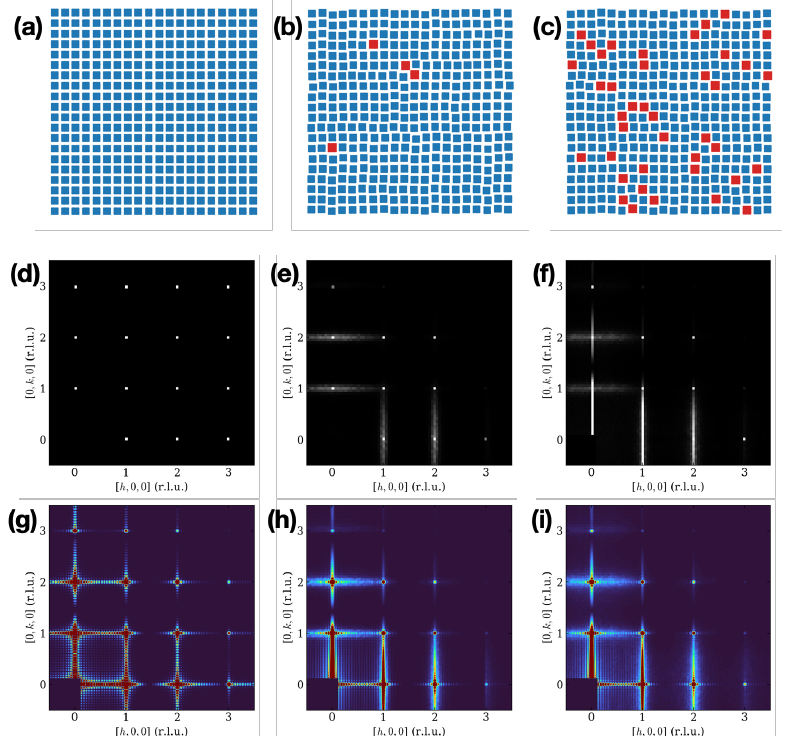
Figure 9. Top row: atomic configurations 20 × 20 × 1 SLs with variable degree of SDE: ( a ) 0%, ( b ) 2%, and ( c ) 5%. Red squares indicate sites occupied by the larger NC size. Middle row: ( hk 0) reciprocal lattice planes for the degree of SDE: ( d ) 0%, ( e ) 2%, and ( f ) 5%. The diffracted intensities were calculated using a sampling step of 1/20 SC’s unit cells to avoid finite size-effects contributions to the calculated intensities. The FT of the simulated crystal can be written as F ( q ) = F ∞ ( q ) (cid:78) Box ( q ) , where F ∞ ( q ) is the structure factor of the infinite crystal, and Box ( q ) the FT of the shape function of the finite crystal. This shows that it is possible to avoid the contribution fo limited size effects by calculating the diffracted intensity where the function Box ( q ) ≡ 0. Bottom row: ( hk 0) reciprocal lattice planes for the degree of SDE: ( g ) 0%, ( h ) 2%, and ( i ) 5%. The diffracted intensities were calculated using a sampling step of 1/80 SC’s unit cells to display finite size-effects contributions to the calculated intensities. All intensities are in electron units and the color maps scale is fixed to 10 − 2 of the strongest Bragg peak to make diffuse effects visible. Origin (000) peak purposely